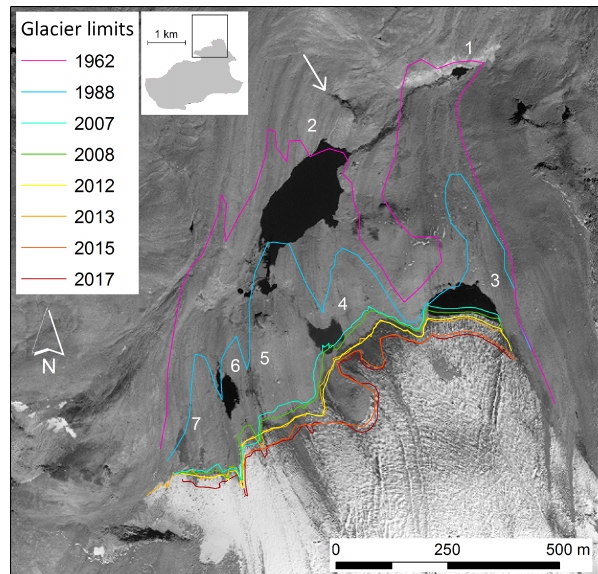
Figure 2. Retreat of the Adygine glacier tongue between 1962 and 2017. 1–7 are the proglacial lakes. The arrow marks the rock out- crop (riegel). Base image: Worldview-2